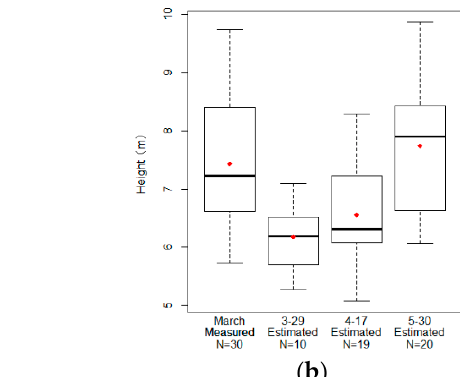
Figure 8. Tree height estimated RMSE and R 2 values of TM ( a ) and FV ( b ) on all three dates. The blue dots and lines are for the RMSEs, while the red dots and lines are for the R 2 values.